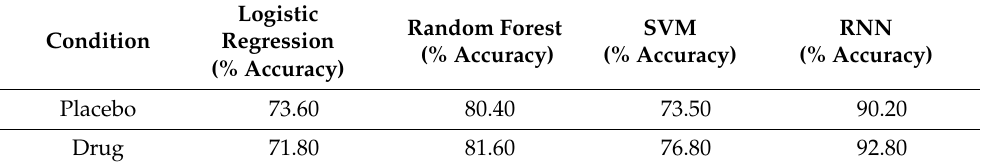
Figure A1. EEG Sensor Placement, the signals of each sensor helps in studying the activity of the particular region of the brain. This further helps in functional connectivity studies of the brain. Table A1. Accuracy of Classifying Placebo vs. Drug induced Memory Task conditions.